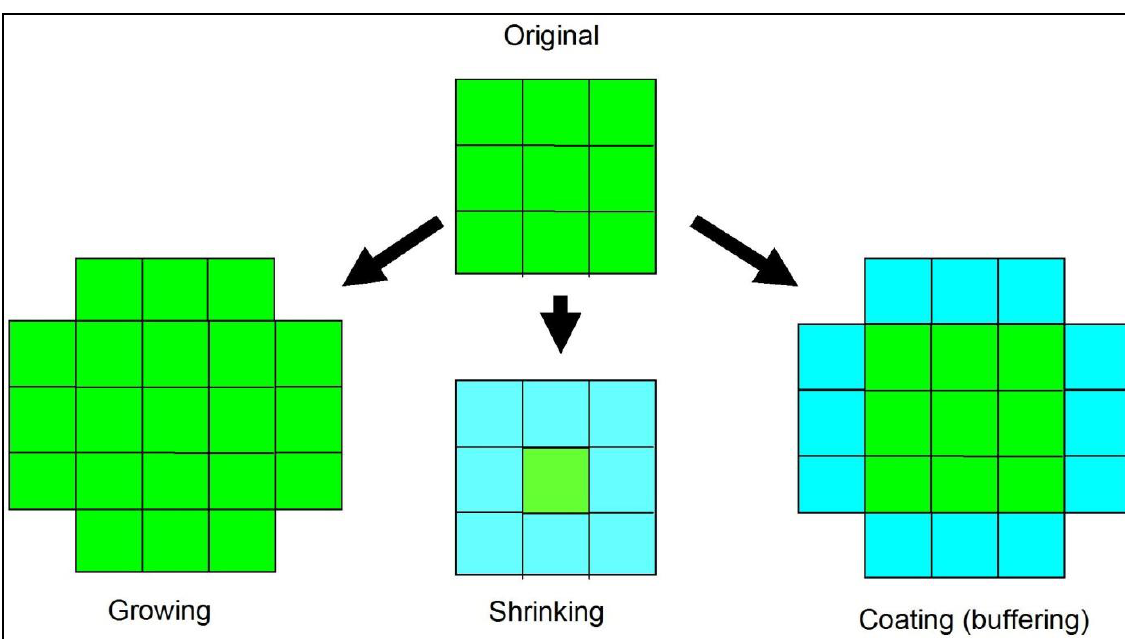
Figure 3. Pixel-based object resizing modes showing the principles of growing (adds one row of pixels on the outside of the existing object), shrinking (subtracts one row of pixels along the outer edge of the object) and coating (adjoins one row of pixels on the outside of the existing